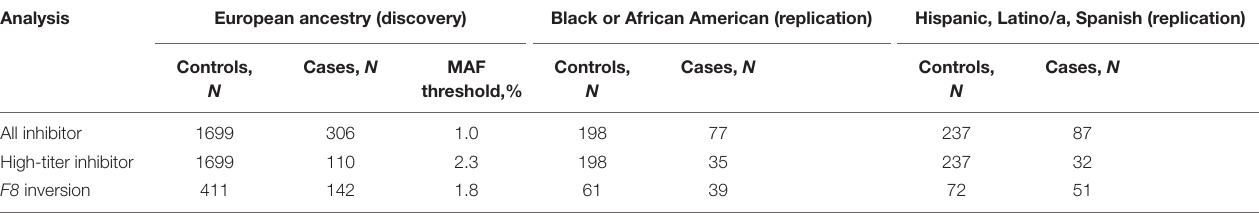
TABLE 1 | HA inhibitor cohort definitions and case-control counts.